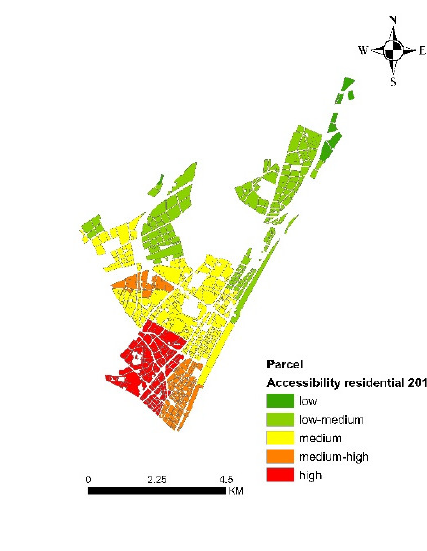
Figure 1. Various levels of study data of the Jiangan district at the Parcel level: ( a ) Wuhan district; ( b ) multimodal network of Jiang’an district_2012; ( c ) parcels by building type (2012); ( d ) accessibility to residential activities (2012).